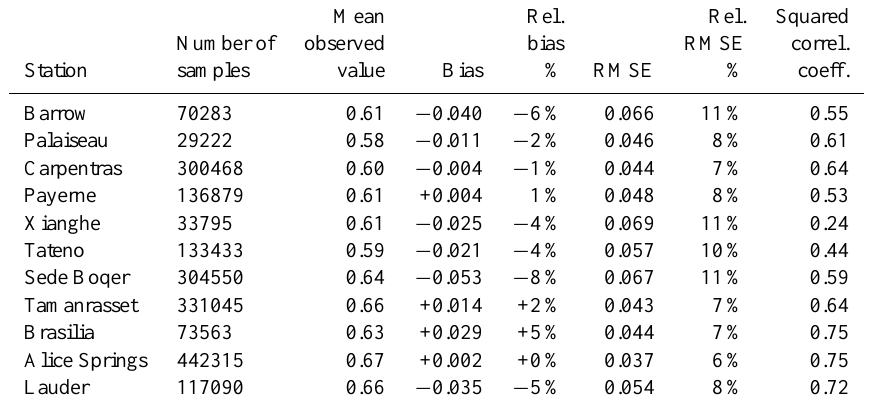
Table 5. Comparison between clear-sky beam clearness indices on horizontal surface measured by BSRN and estimated by